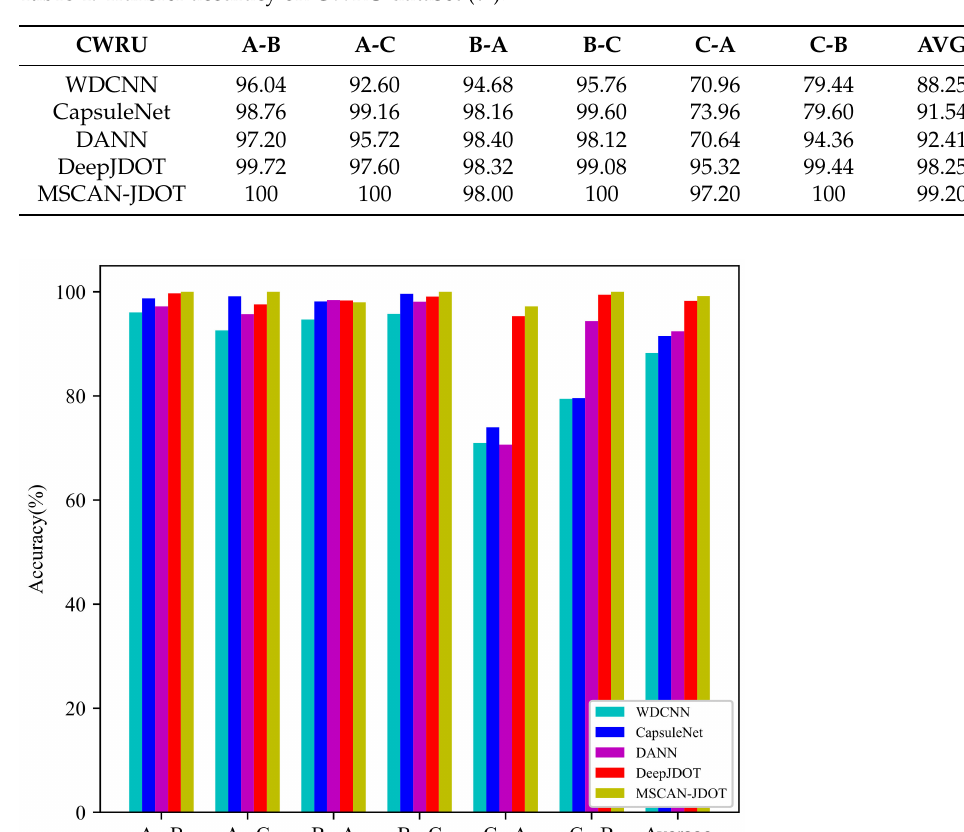
Table 4. Transfer accuracy on CWRU dataset (%).